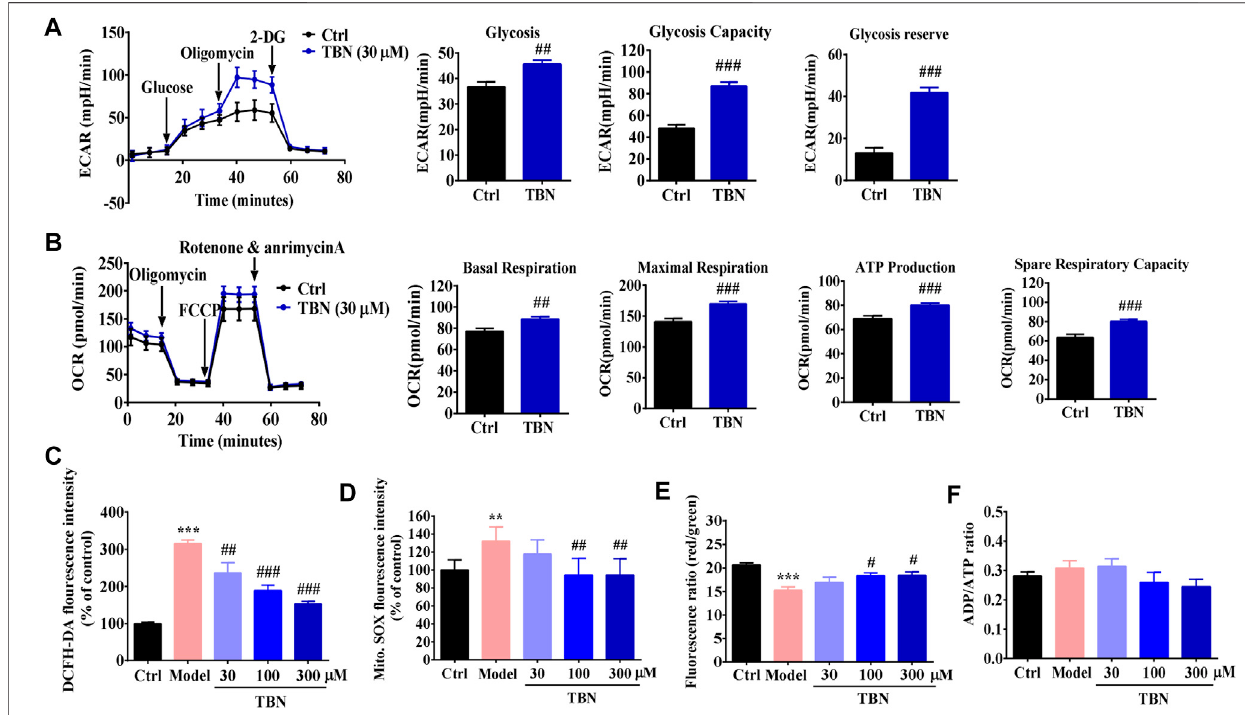
FIGURE6 | TBNimprovesmitochondrial functionin HK-2 cells. (A) Aglycolysis stresstest wasused tomeasure glycolytic functionofHK-2 cells incubated with or without TBN. Representative graph of ECAR at baseline following sequential addition of 10 mM glucose, 1 µM oligomycin, and 50 mM 2-deoxyglucose (2-DG). Glycolysis,Glycolyticcapacity,andGlycolyticreservewerecalculated.( B )OCRweremeasuredinHK-2cellsatbaselinefollowingsequentialadditionof1 µMoligomycin, 0.5 µM carbonyl cyanide 4-tri fl uoromethoxy-phenylhydrazone (FCCP), and 0.5 µM each of rotenone and antimycin A. Basal respiration, Maximal respiration, ATP production,andSparerespirationcapacitywerecalculatedinHK-2cells.Fortwo-groupcomparisons,datawereanalyzedusinganunpairedStudent ’ st-test. ## p < 0.01 and ### p < 0.001vs.Ctrl.CellularROSproduction (C) ,mitochondrialROSproduction (D) ,MMP (E) ,andATPgeneration (F) wereanalyzedinhighglucose-inducedHK- 2cells. Datarepresent mean ± SEM.Statisticalsigni fi cance wasevaluatedby1-way ANOVAin J-MfollowedbyTukey ’ stests. ** p < 0.01and *** p < 0.001vs. ctrlgroup. # p < 0.05, ## p < 0.01, and ### p < 0.001 vs. model